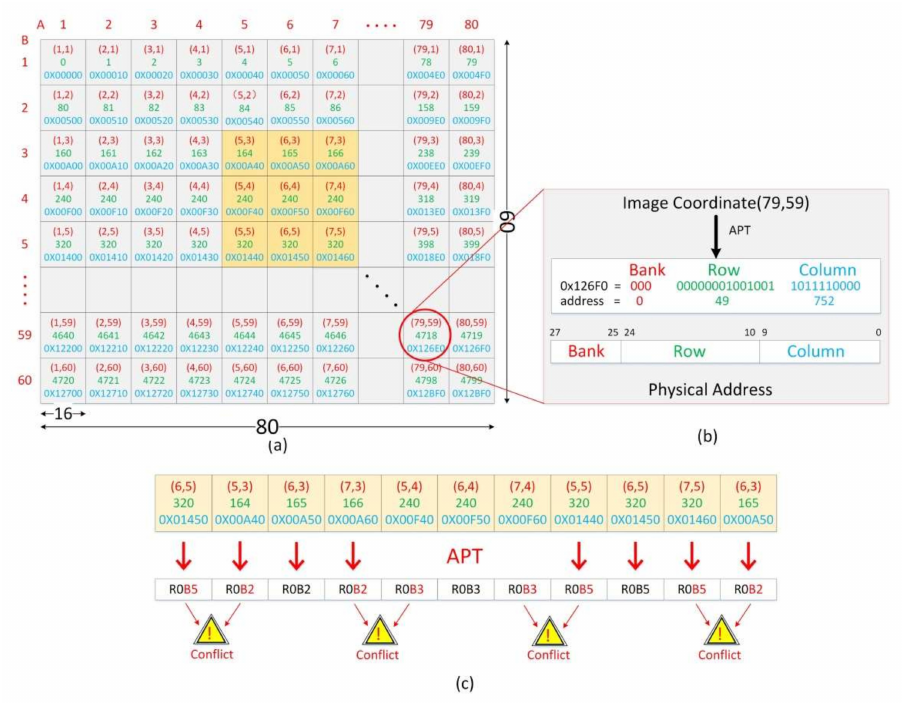
Figure 3. Address and pixel transactions in the accelerator. ( a ) Sequential access mapping APT. ( b ) Address mapping. ( c ) Part of the 2D access mapping